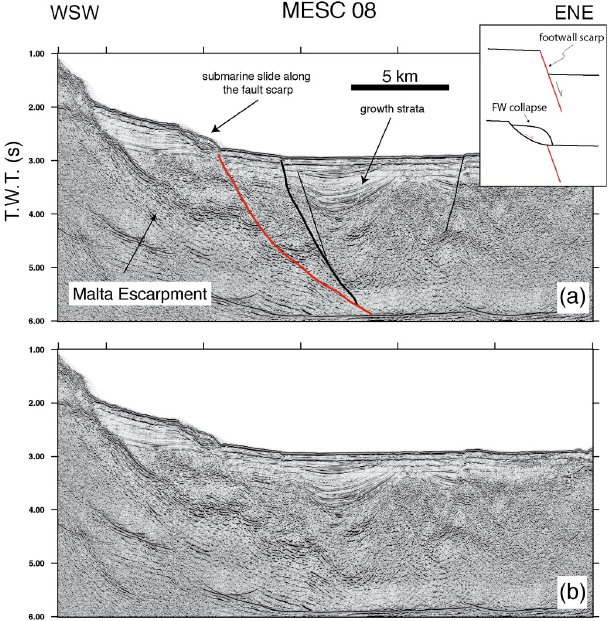
Fig. 3. Seismic profile MESC 08. (a) Interpreted line showing the structural features in the northern sector of the eastern Sicily slope. The steep eastward-dipping package of reflectors represents the Malta Escarpment. Note the two normal faults, one of which is active (in red) and cuts the sea floor. The slide is affecting the footwall of the active splay of the major normal fault, located to the west. Vertical exaggeration ca. 3.5. The inset shows the concep- tual interpretation of the slide/fault relationship. (b) Non interpreted line. The detail of the slide is given in Fig. 4. Location in Fig.